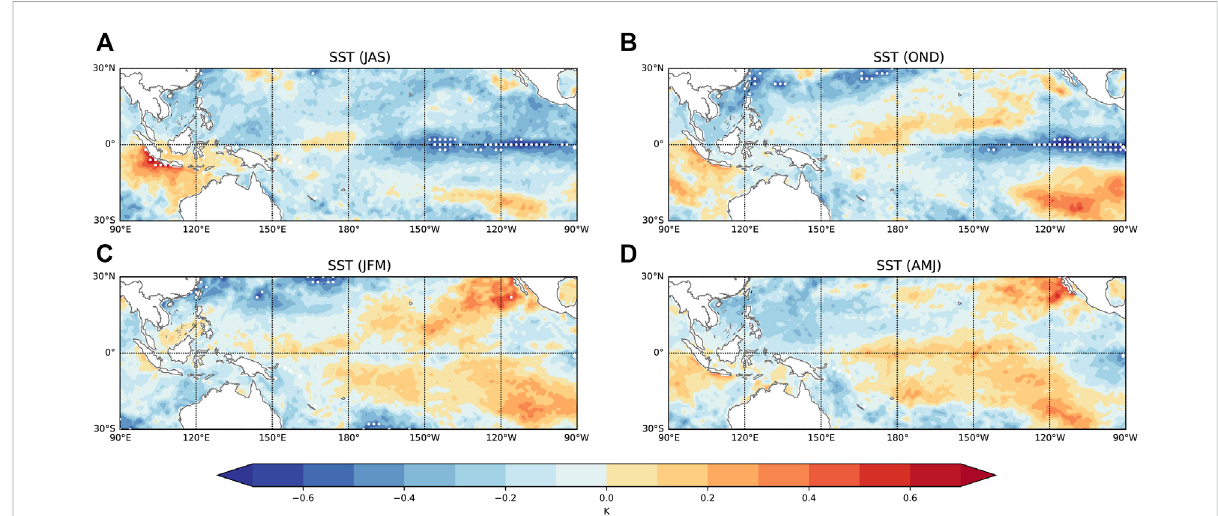
FIGURE 6 Compositemap of SST difference betweensolar maximum and solar minimum in (A) the preceding July-August-September, (B)